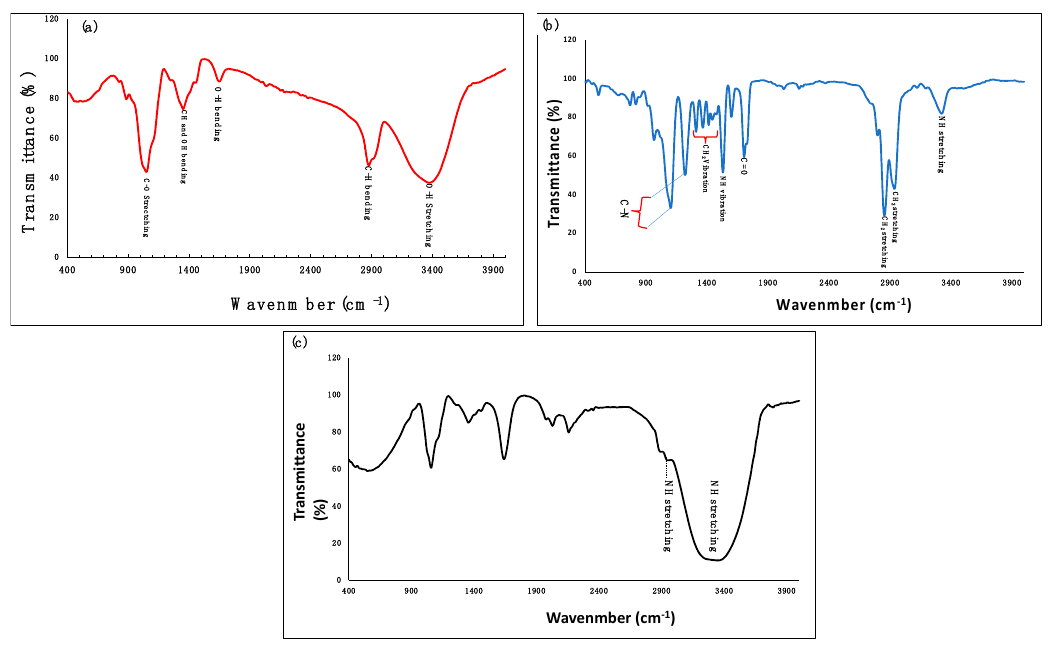
Figure 7. FTIR of ( a ) HPS, ( b ) PU and ( c ) AgNPs-3@NFs.